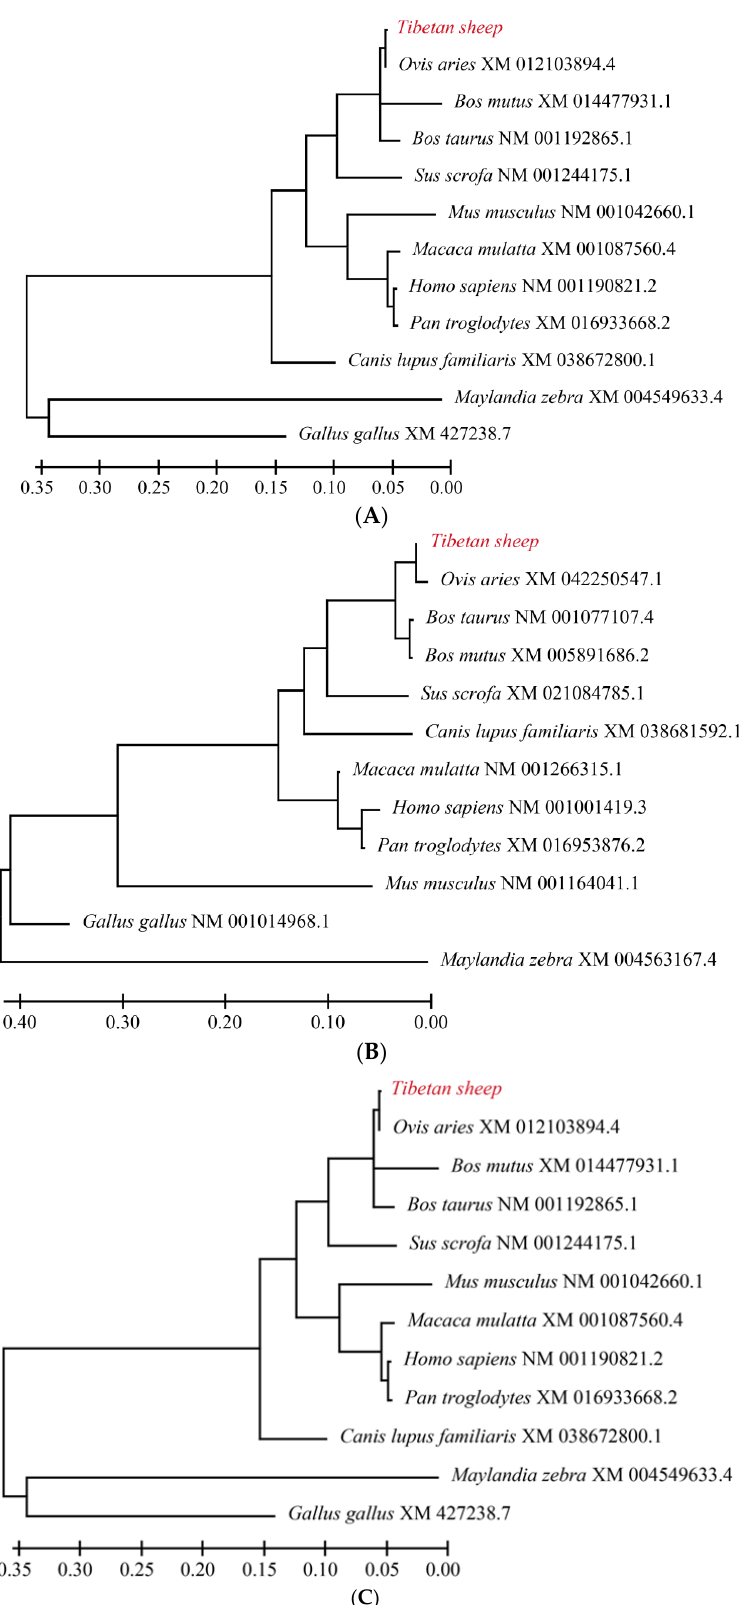
Figure 2. Amino acid sequence alignments of SMAD4 ( A ), SMAD5 ( B ) and SMAD7 ( C ) form Ovis aries . Bos Taurus , Bos mutus , Homo sapiens , Sus scrofa , Mus musculs , Maylandia zebra , Pan troglodytes , Macaca mulatta , Gallus gallus and Canis lupus familiaris .